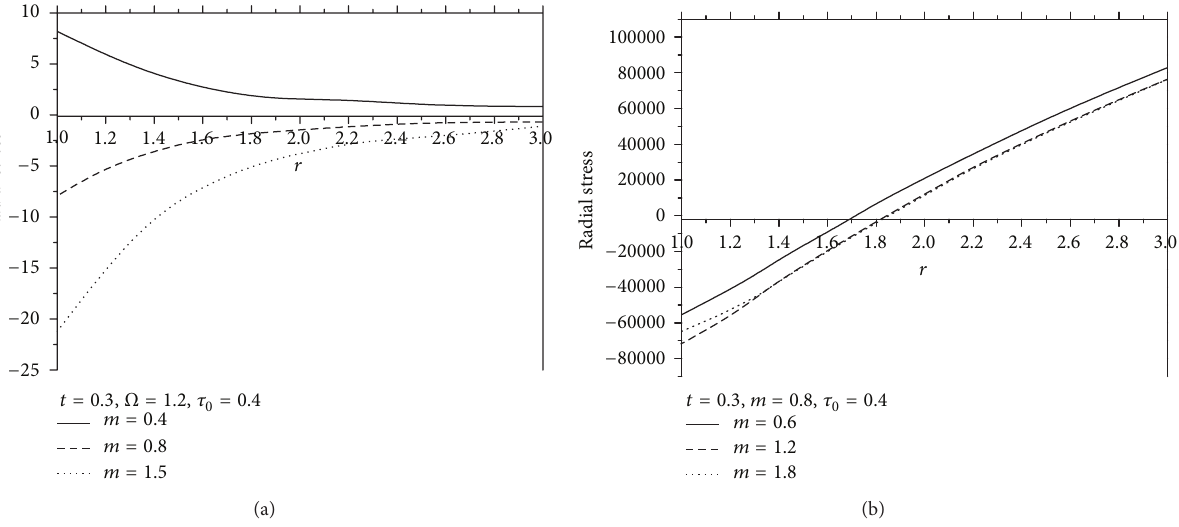
Figure 5: Variation of radial stress 𝜎 𝑟𝑟 with radius 𝑟 (thermoelastic diffusion nonhomogeneity medium).